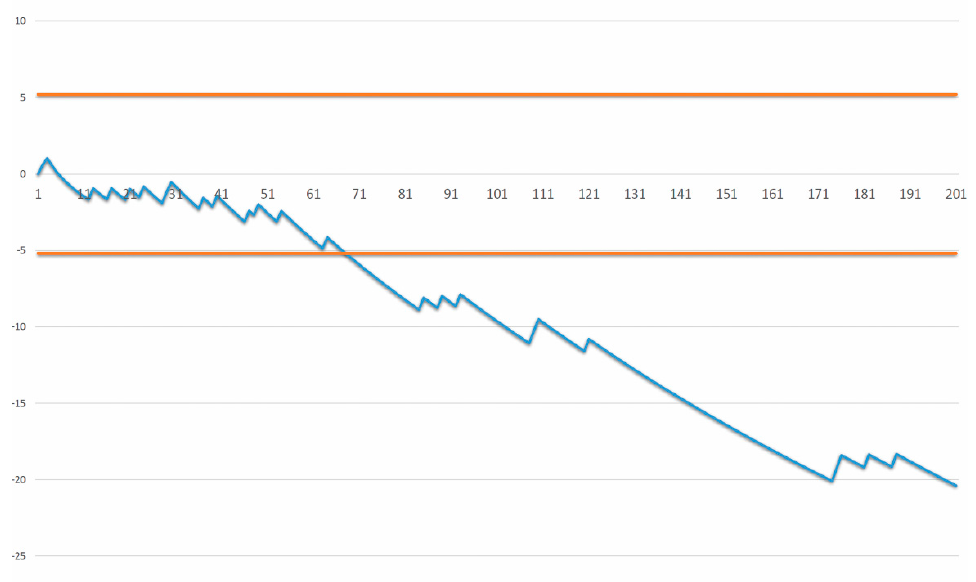
Figure 3. Risk-adjusted sequential probability ratio test (RA-SPRT) chart for complications according to comprehensive complication index (cut off value = 40). The x-axis represents the operation number. The y-axis represents a cumulative log-likelihood ratio value.